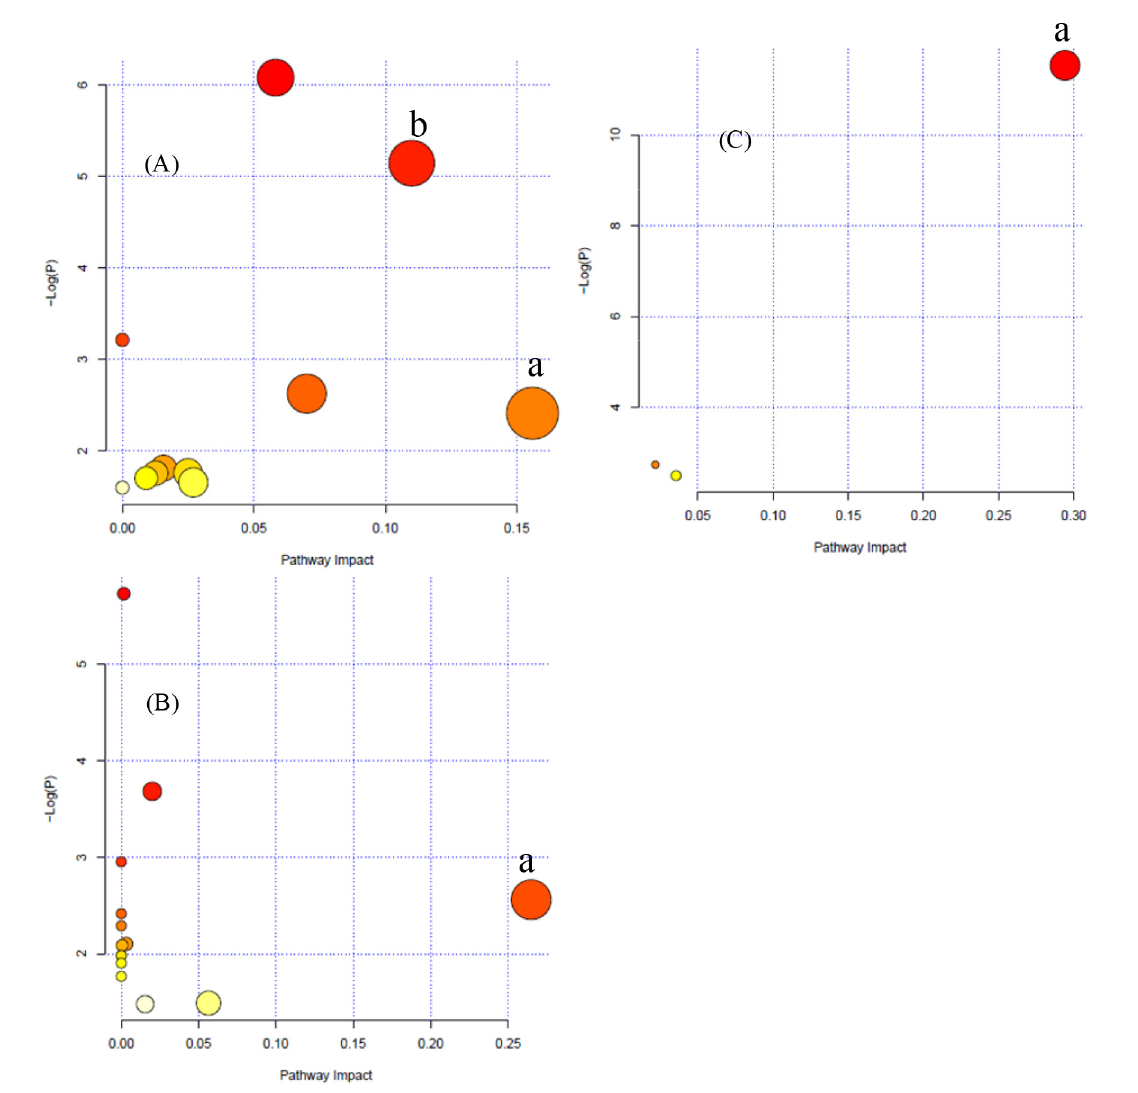
Fig 5. Metabolomics pathway analysis (MetPA) summary. (A) Urine, a) sphingolipid metabolism and b) lysine biosynthesis; (B) hippocampal tissue, a) alanine, aspartate, and glutamate metabolism; and (C) Plasma, a) sphingolipid